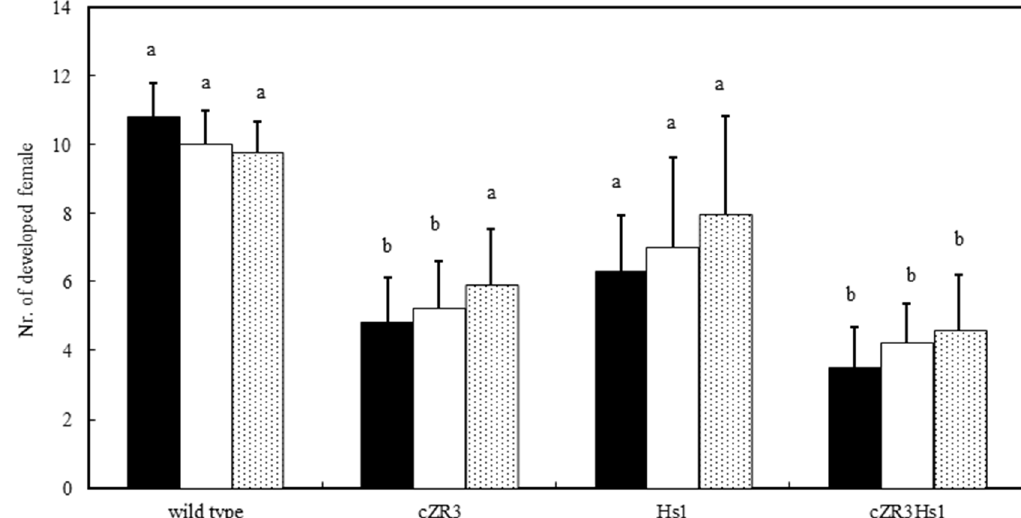
Figure 5. Numbers of developed female per plant on transgenic and wild type plants according to cyst nematode test in vitro. Wild type means non‐transgenic oilseed rape ( B. napus L.); transgenic plants consist of cZR3 and Hs1; and cZR3Hs1 means cZR3 , Hs1 pro-1 and cZR3Hs1 pro-1 populations. The black, white, dotted rectangles represent independent wildtype plants and transgenic lines. The averages ± standard errors from three separate replicates are shown. The values with different letters are significantly different at p ≤ 0.05 as determined by Duncan’s test (a, b).